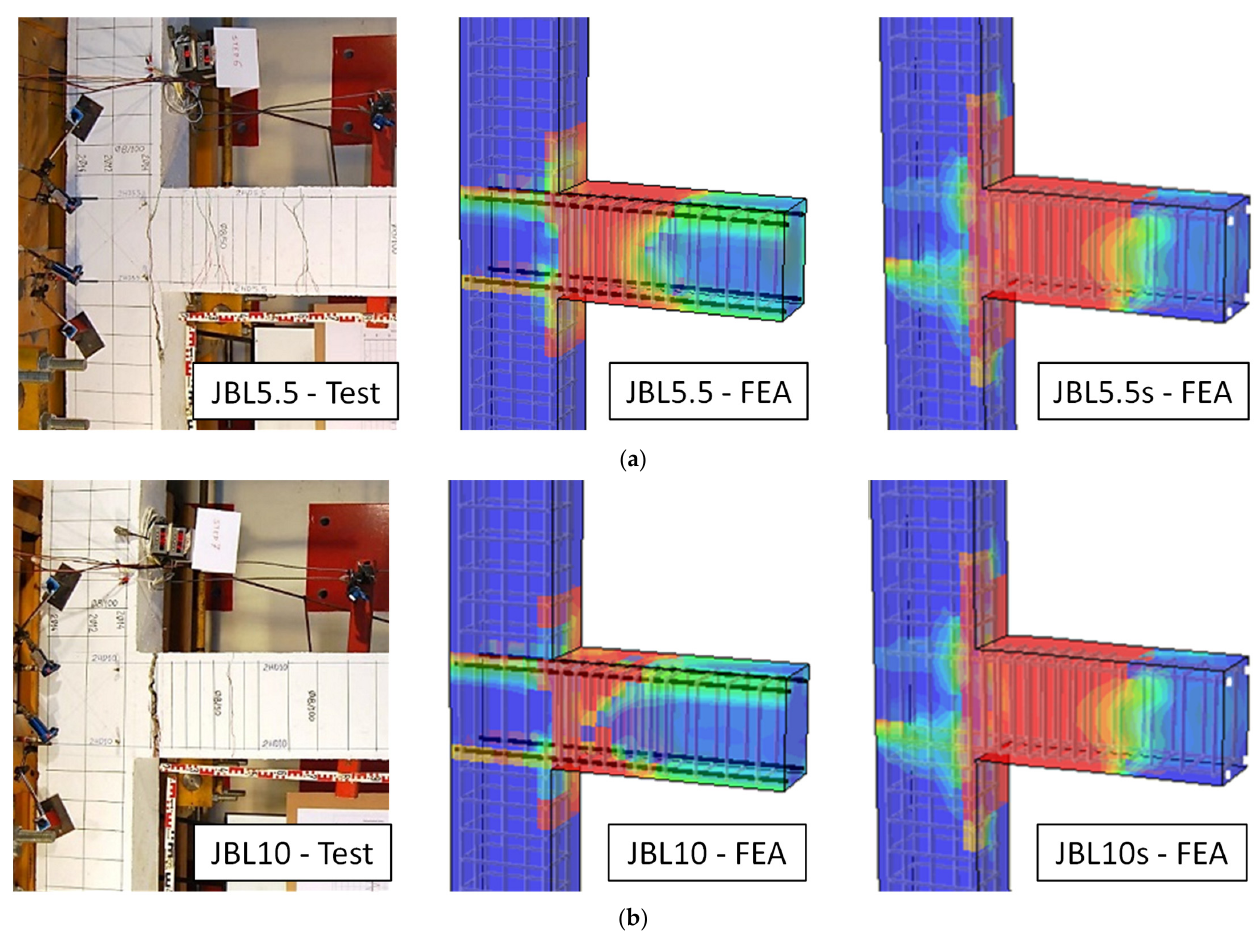
Figure 12. Verification of FE model prediction of damage area: ( a ) JBL5.5—Test, JBL5.5—FEA, JBL5.5s—FEA and ( b ) JBL10—Test, JBL10—FEA, JBL10s—FEA.